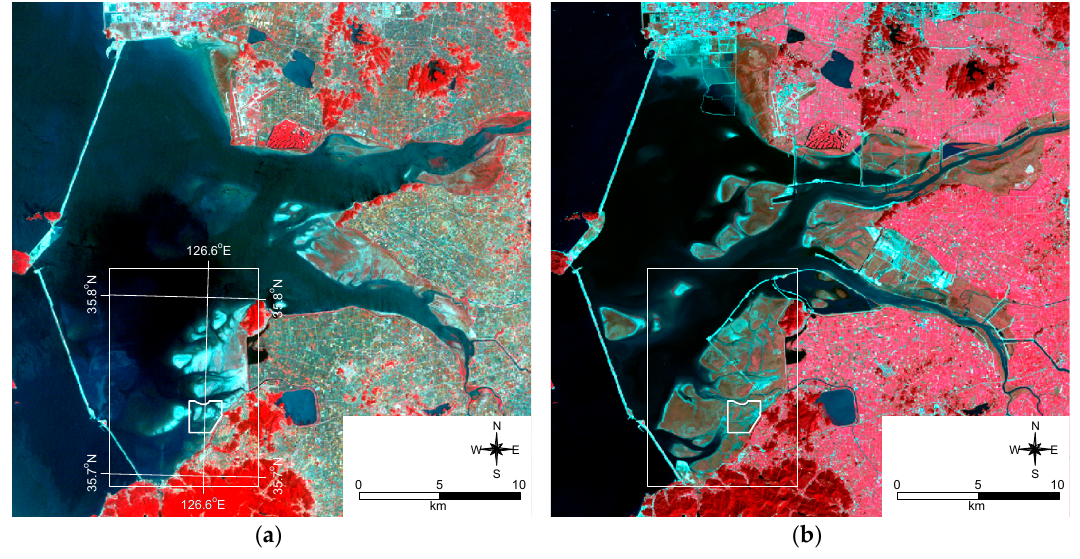
Figure 1. Overview of the Saemangeum area: ( a ) 1 June 2009, 4-3-2 Landsat 5; ( b ) 5 October 2014, 5-4-3 Landsat 8. The EL is maintained at approximately − 1.5 m; insets show the location of the study area in Figure 2.